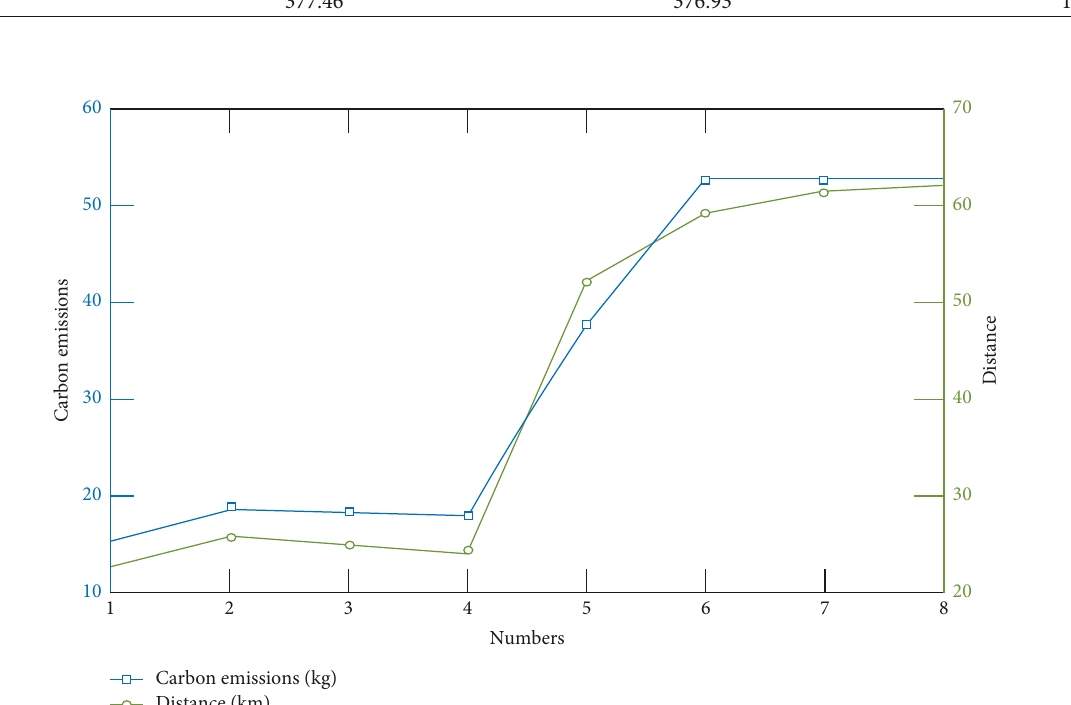
Figure 4: Relationship between distance and carbon